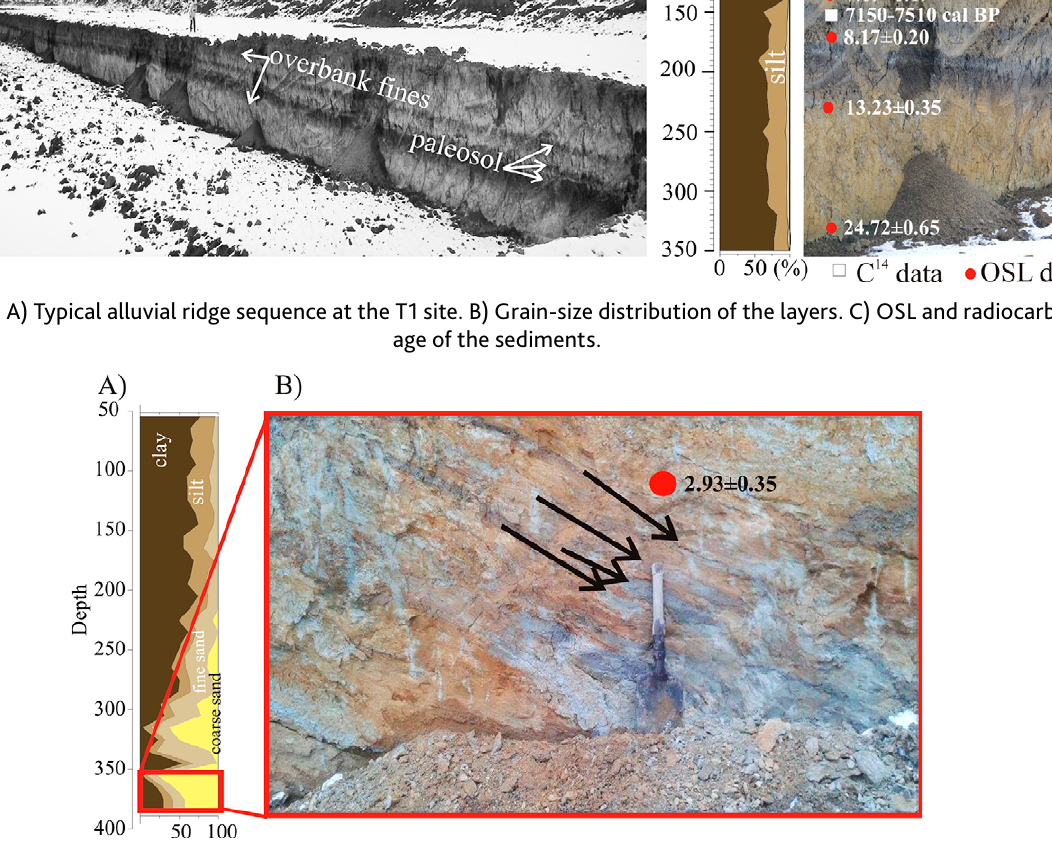
Within the point-bar sediments sandy and silty (indicated by arrows) alternate. The younger most point-bar layer was dated by OSL measurement.